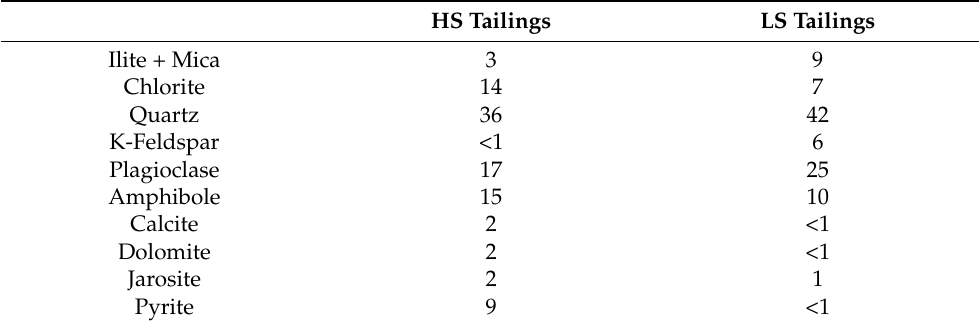
Table 2. Mineralogical composition of the HS tailings and LS tailings, as estimated by Rietveld analysis of XRD patterns